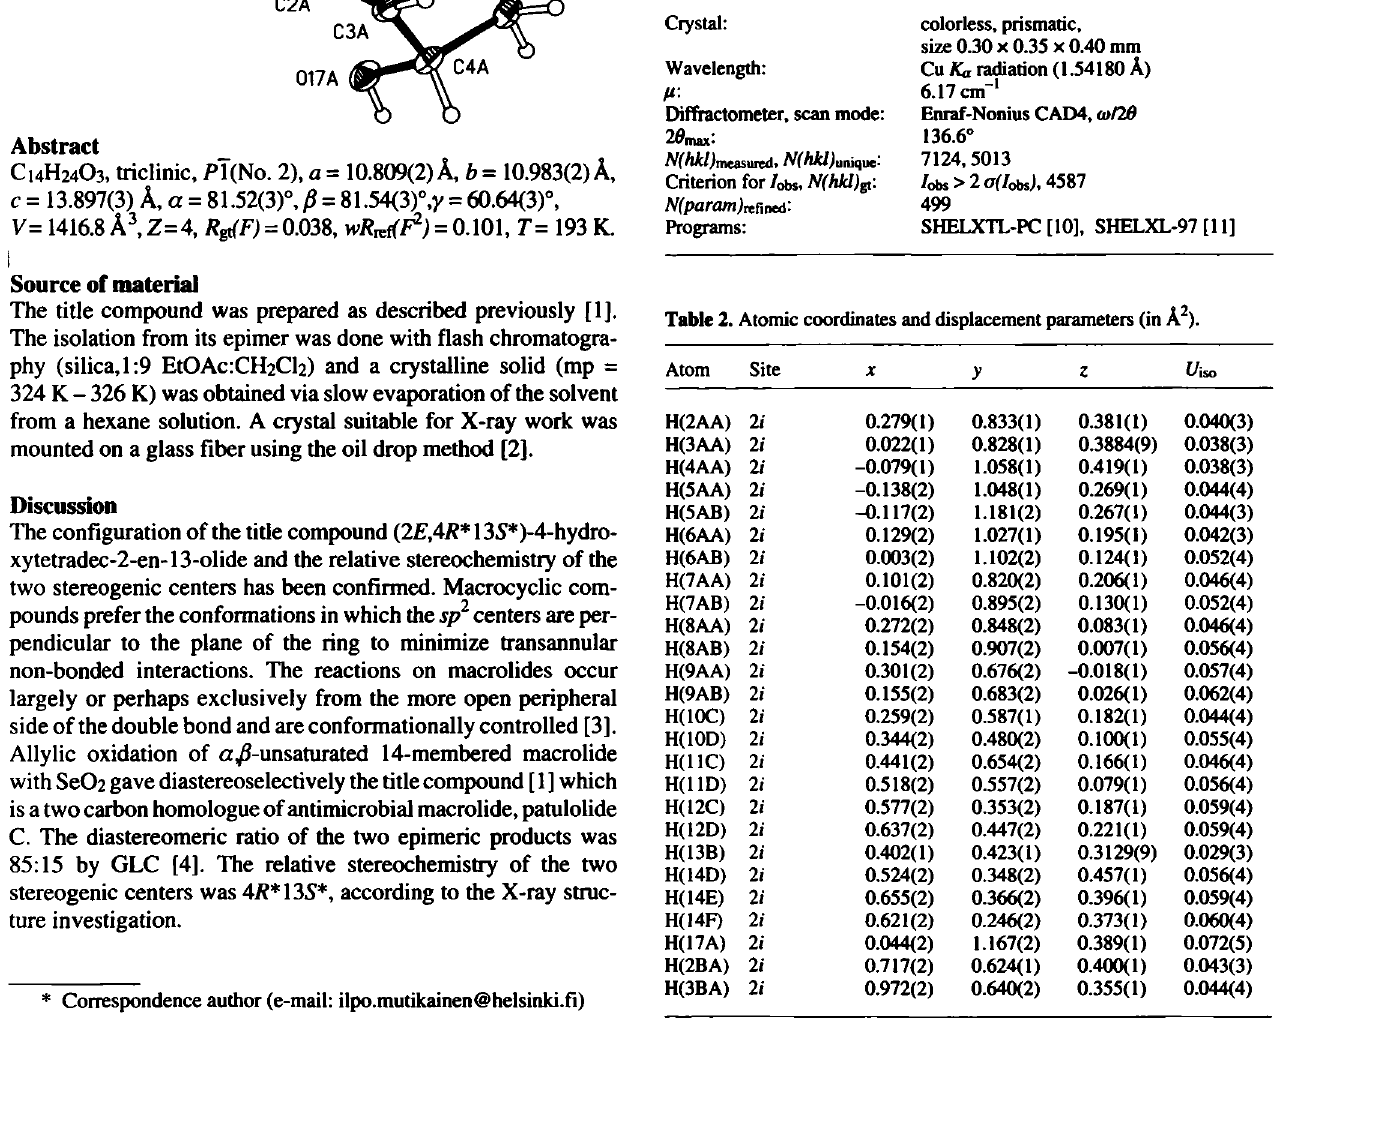
Table 1. Data collection and handling.